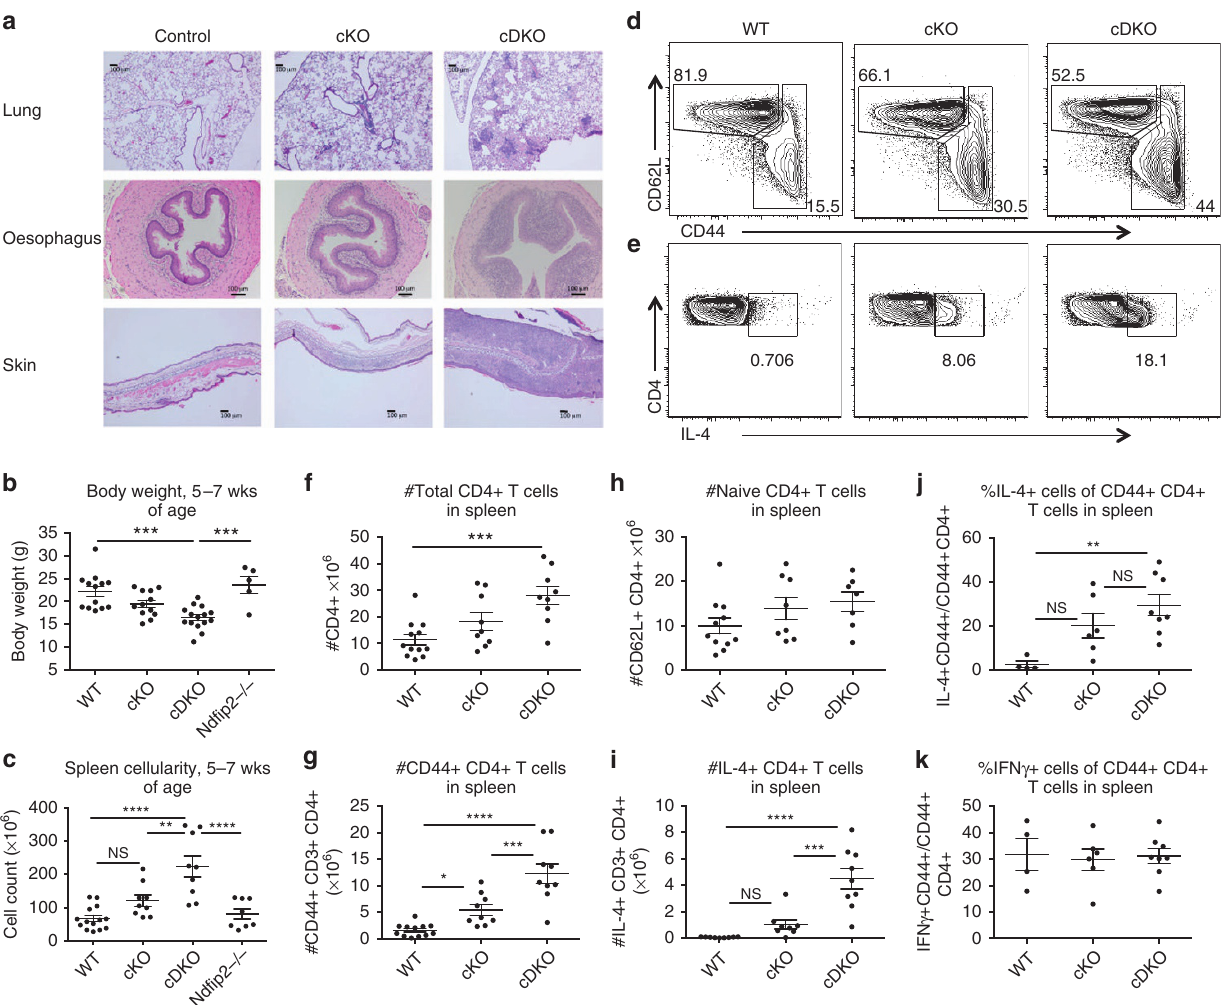
Figure 2 | Ndfip2 deficiency exacerbates inflammation in Ndfip1 fl/fl CD4Cre þ mice. ( a ) H&E-stained sections of oesophagus, lung and skin from representative 8-week-old control, Ndfip1 fl/fl CD4 Cre þ (cKO) and Ndfip2 (cid:2) / (cid:2) Ndfip1 fl/fl CD4 Cre þ (cDKO) mice (bar represents 100 m m). ( b , c ) Body weight ( b ) and ( c ) spleen count of 5–7-week-old WT, cKO, Ndfip2 (cid:2) / (cid:2) and cDKO mice. Mean ± s.e.m. n ¼ 5–15 mice. ( d , e ) Representative flow cytometry analysis of splenic CD3 þ CD4 þ Tcells, showing ( d ) expression CD44 and CD62L and ( e ) intracellular levels of IL-4 after ex vivo stimulation with PMA/ ionomycin in the presence of BFA. ( f – i ) Quantification of ( f ) the number of CD4 þ Tcells, ( g ) naive CD62L high CD4 þ Tcells, ( h ) CD44 þ CD4 þ Tcells and ( i ) IL-4 þ CD4s from spleen analysed by flow cytometry. Mean ± s.e.m., n ¼ 7–12 mice. ( j , k ) Quantification of percent IL-4 þ or IFN g þ CD4 þ Tcells among CD44 high Tcells. Mean ± s.e.m., n ¼ 4–7 mice. P values calculated by one-way ANOVA with Holm–Sidak test for multiple comparisons: * P o 0.05,